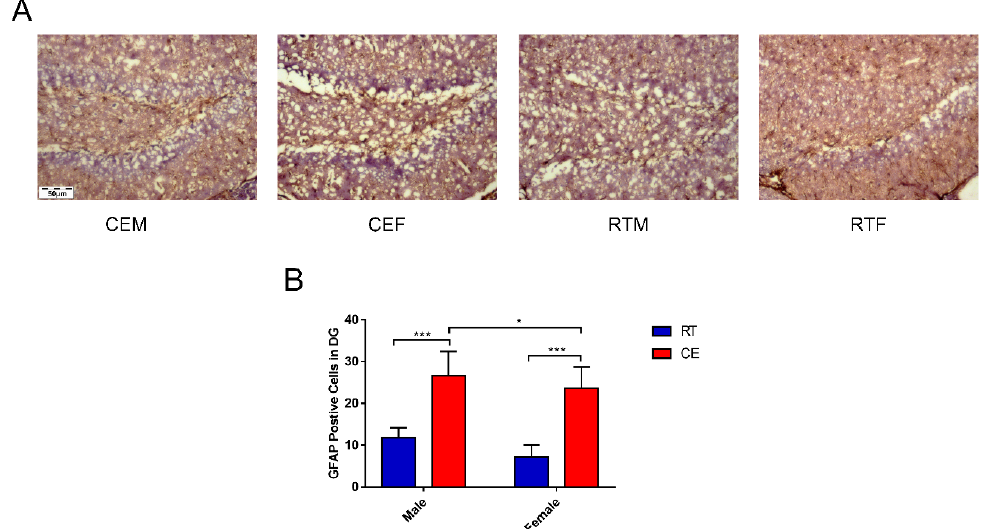
Figure 4. Immunohistochemical detection of the astrocyte marker glial fibrillary acidic protein (GFAP) in the dentate gyrus (DG) and evaluation of the structural integrity of DG neurons by Nissl staining in cold-stressed mice. ( A ) GFAP expression in the DG. Scale bar = 50 µ m. ( B ) Quantification of GFAP-positive cells in the DG. Differences between room temperature male (RTM) and cold exposure male (CEM), room temperature female (RTF) and cold exposure female (CEF), and CEM and CEF groups were evaluated by two-way analysis of variance. Results are expressed as the mean ± SD ( n = 6) of four independent experiments. * p < 0.05, *** p < 0.001.